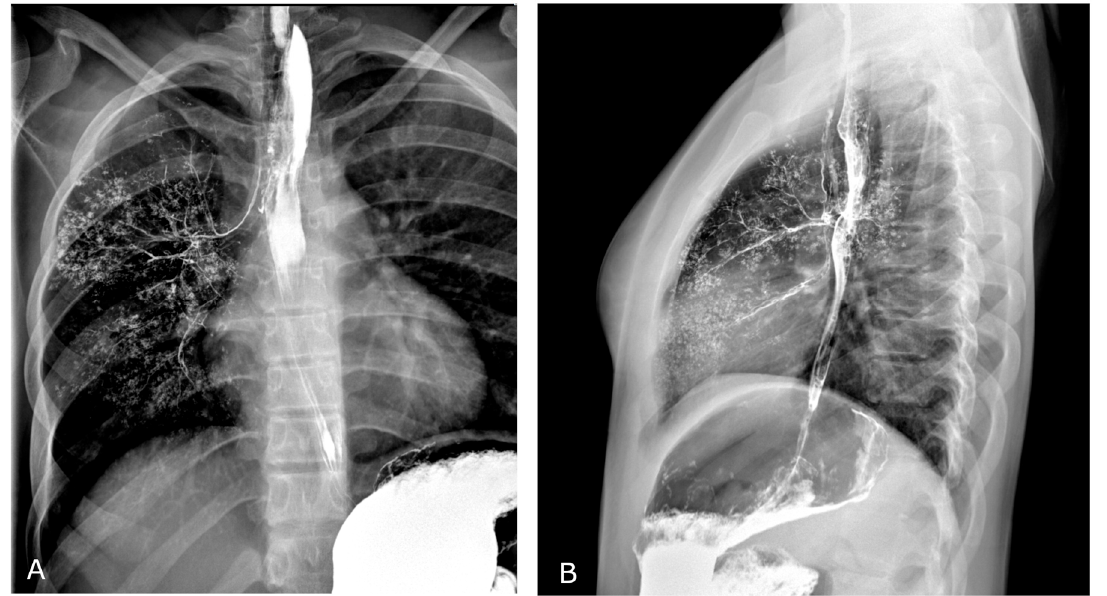
Figure 4. Barium-swallowing study performed two years before (study recovered from patient’s medical record and performed in a different institution). Frontal ( A ) and lateral ( B ) views show opacification of right bronchial tree due to transit of barium-containing contrast agent through a small tracheoesophageal fistula.